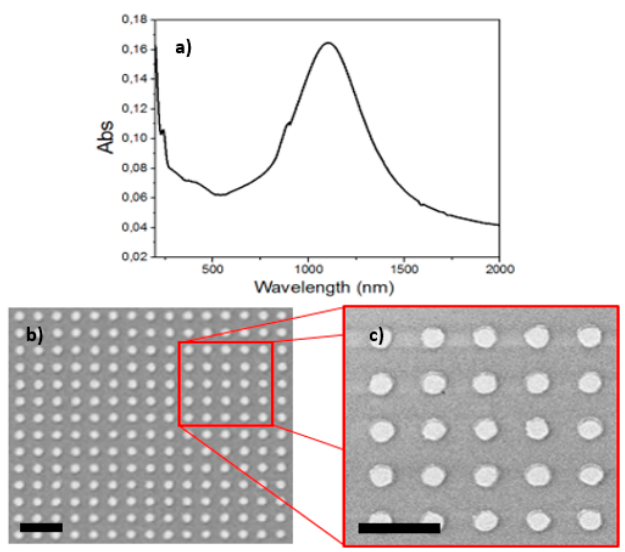
Figure 2. ( a ) Optical absorption spectrum in the 200–2000 nm range and ( b,c ) SEM images of Au NDs array on quartz with diameter of 150 nm and height of 5 nm. Scale bars are 500 nm.